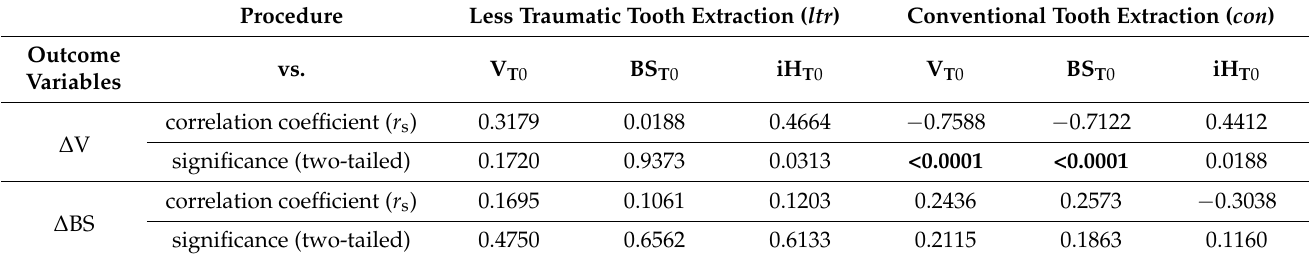
Table 2 . Spearman’s correlation coefficients r s with significances between outcome variables and overall anatomical variables for alveolar ridge modification in two groups, less traumatic tooth extraction ( ltr ) and conventional tooth extraction ( con